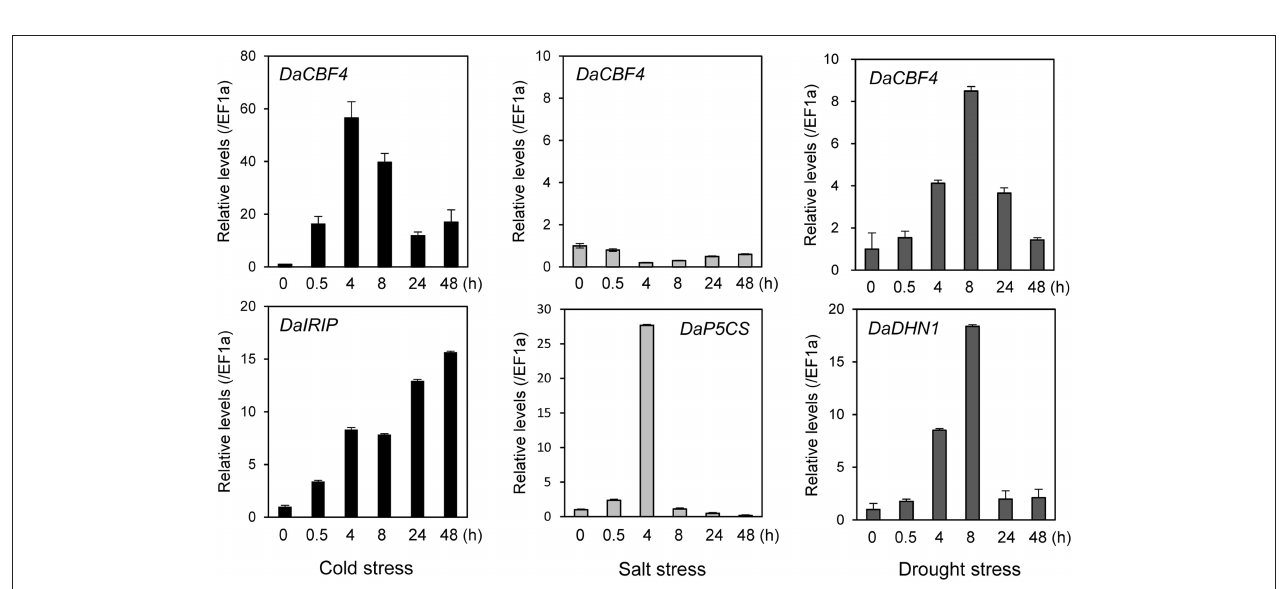
FIGURE 2 | Expression of DaCBF4 in D. antarctica under various abiotic stress conditions. The DaCBF4 expression levels were measured by RT-qPCR with total RNA from D. antarctica leaves under cold (4 ◦ C), salt (150mM NaCl), or drought (air dried on a filter paper at 15 ◦ C) stress. The D. antarctica EF1a gene was used as an internal control for normalization. The expression level of DaCBF4 grown on normal MS at 15 ◦ C was used as a control (calibrator for quantification) and was assumed as 1. Error bars represents standard deviation of means ( n = 3). The DaIRIP , DaP5CS , and DaDHN1 genes were positive controls for cold, salt, and drought stresses, respectively. DNA sequences of gene-specific primers used for RT-qPCR are shown in Supplementary Table 2.